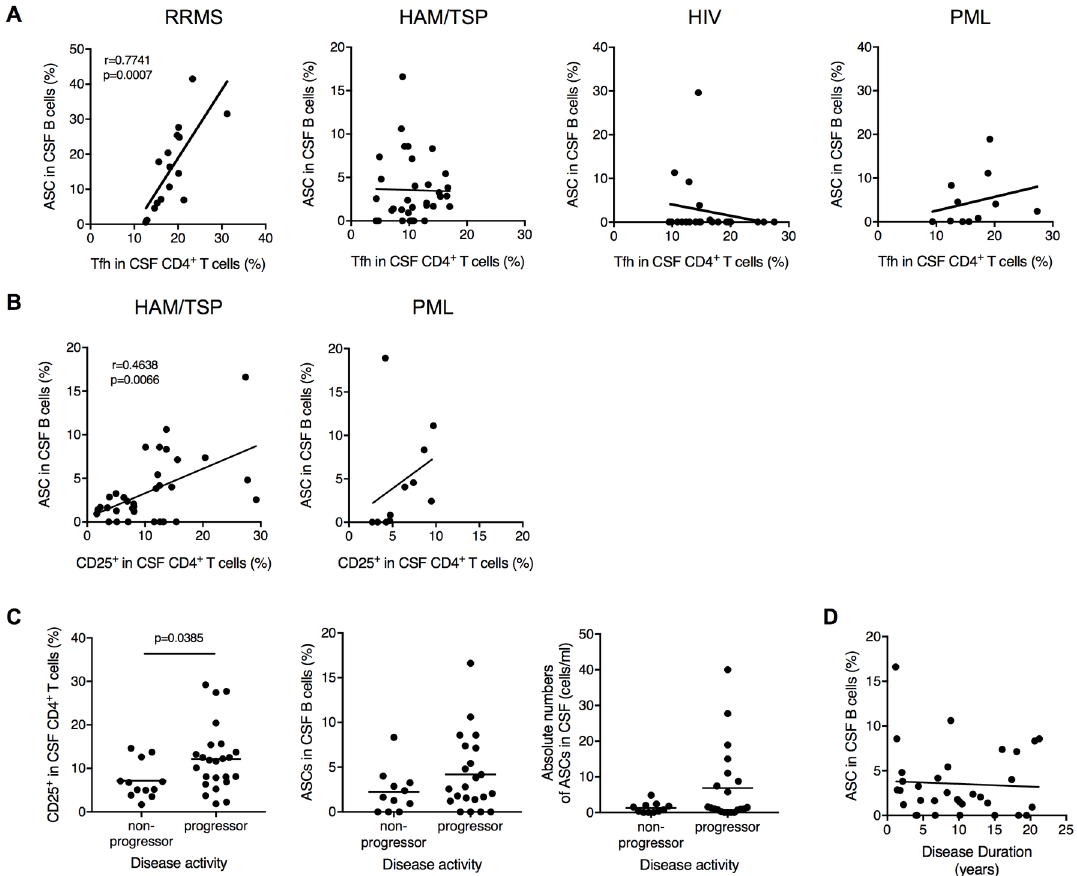
Fig 5. Correlation between ASC and CD4 + T cell subsets. (A) Correlation of ASCs with memory Tfh cells in CSF of patients with MS, HAM/TSP, HIV and PML using Spearman’s rank correlation test. (B) Correlation of ASCs with CD4 + CD25 + T cells in CSF of patients with HAM/TSP and PML using Spearman’s rank correlation test. (C) Comparison of frequency of CD4 + CD25 + T cells and ASCs in CSF of HAM/TSP patients between non-progressors and progressors using Mann-Whitney Test. The horizontal line represents the mean. (D) Correlation of ASCs in CSF B cells with disease duration in HAM/TSP patients (n = 32) using Spearman’s rank correlation test.